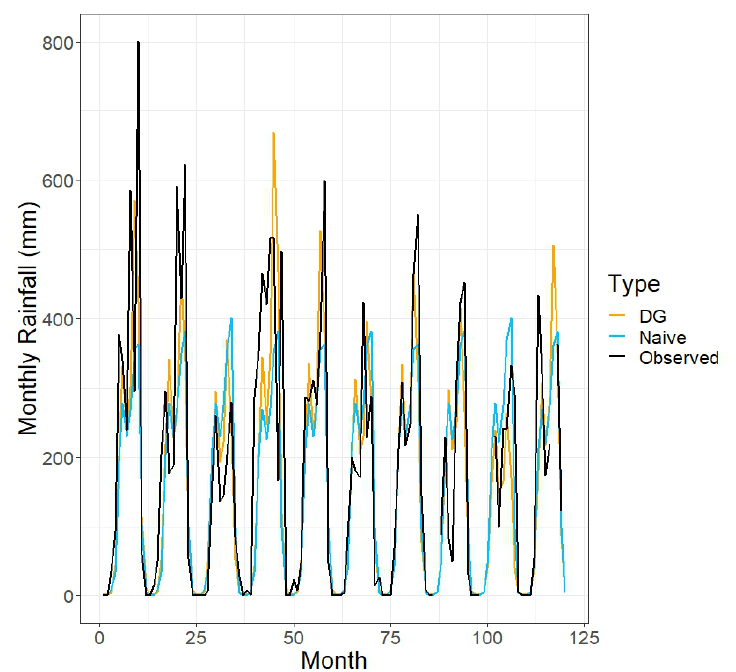
Figure 9. Three-month-ahead predicted (using the double Gaussian and naive approaches) and observed monthly rainfall values at the Nicoya station from 2007 to 2016. “Month” is the number of months since January